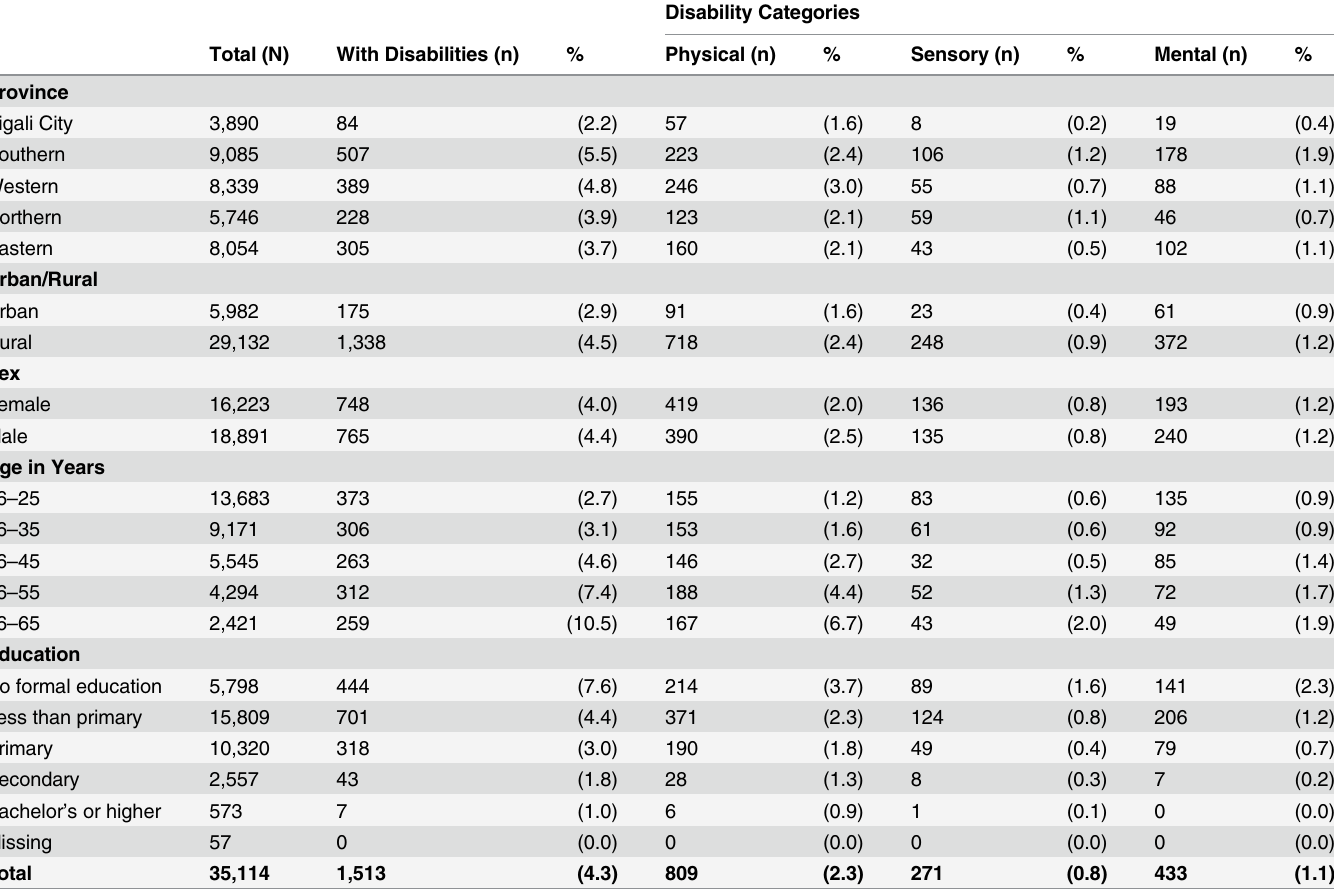
Table 1. Socio-Demographic Characteristics of Working-age Adults with Self-Reported Disabilities in